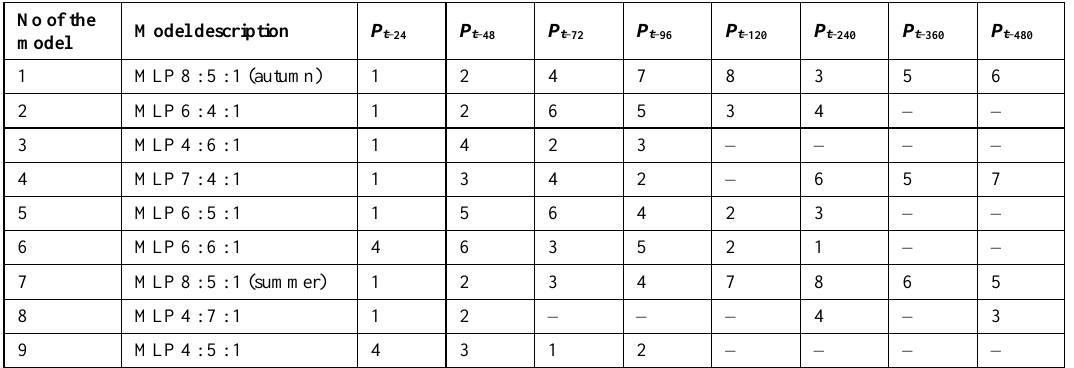
Price volatility Price spikes, % Dataset used to construct the model